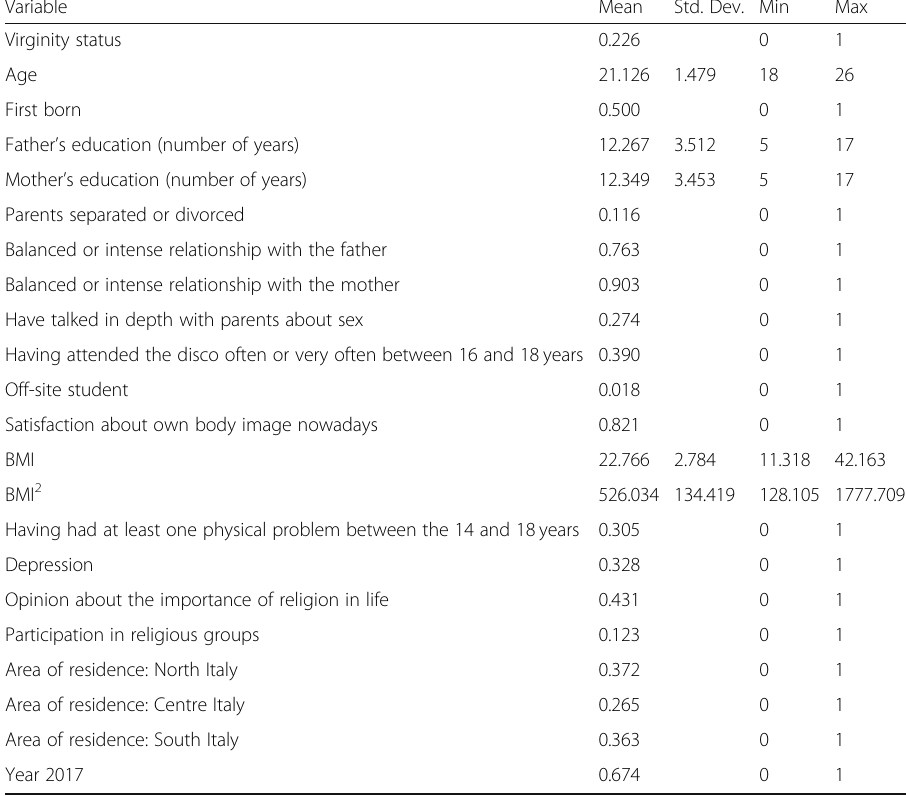
Table 4 Descriptive statistics of the complete sample (2000 and 2017). Males ( n =